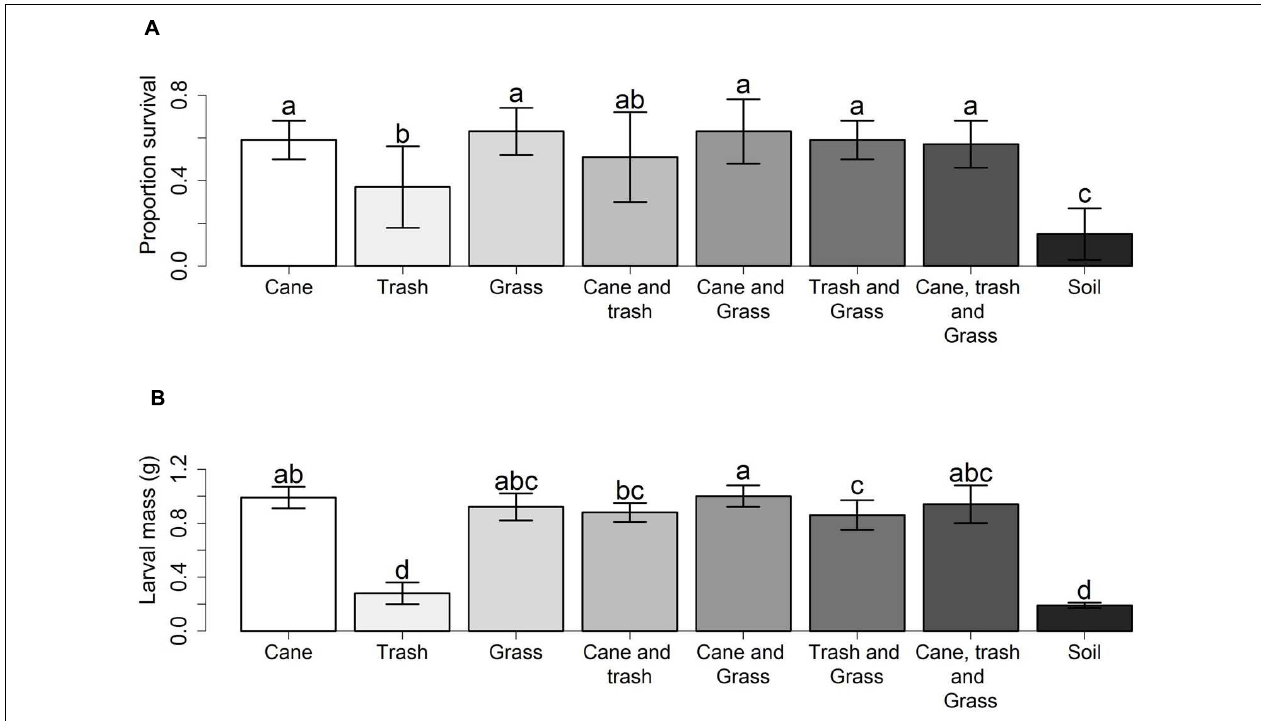
FIGURE 4 | Survivorship and mass of early instar larvae of D. albohirtum . (A) Mean proportion survival ( ± SD), and (B) mean larval mass in grams ( ± SD), of larvae after 4 weeks in bins with food of either sugarcane, Guinea grass, cane trash, combinations of two or three of these, or none of these. Different letters indicate significant effects of treatments. Adapted from Logan and Kettle